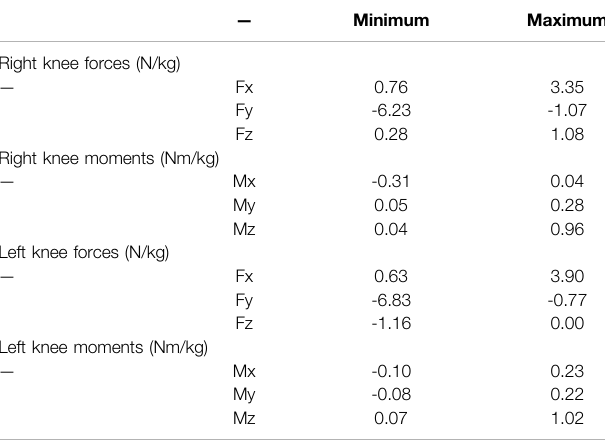
The z -axis, x -axis and y -axis refer to the medial-lateral, anterior-posterior and superior- inferior direction. Positive joint moments denote an internal knee extension, adduction and internal rotation moment,